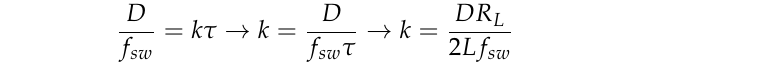
Figure 3. Influence of the damping factor “ d f “ in the instantaneous current waveform ( i (t ) ) in the resonant tank: current with less sinusoidal waveform (orange), current with sinusoidal waveform